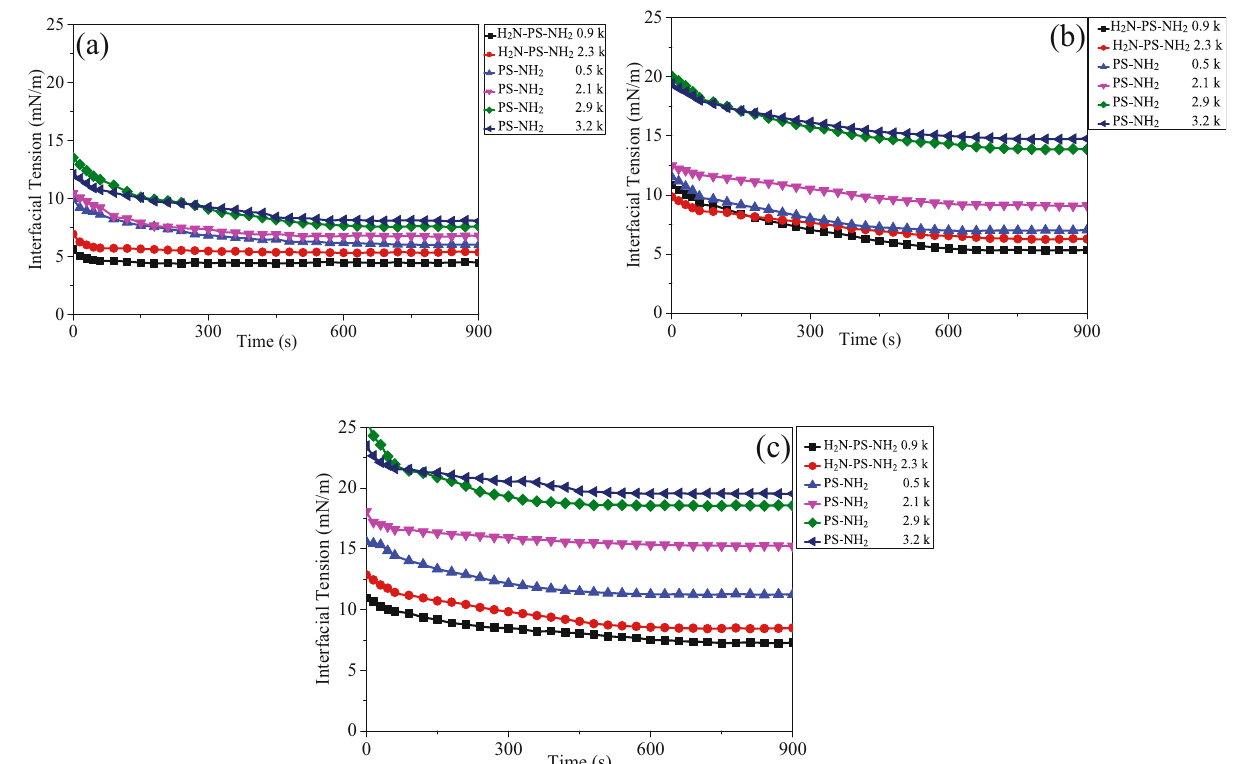
Figure 5: Aminated PS ( 1 mg/mL ) compounding with NPs ( 10 mg/mL ) at pH = 3: ( a ) CDs – SO 3 H; ( b ) CNCs – OSO 3 H; ( c ) GOs – SO 3